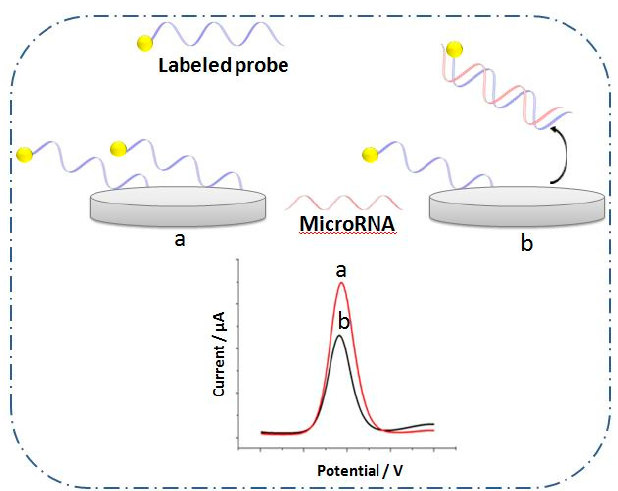
Figure 2. Architecture of electrochemical biosensor based on destroying the adsorption of the labeled probe after hybridization step on the electrode surface ( a ) before and ( b ) after hybridization.